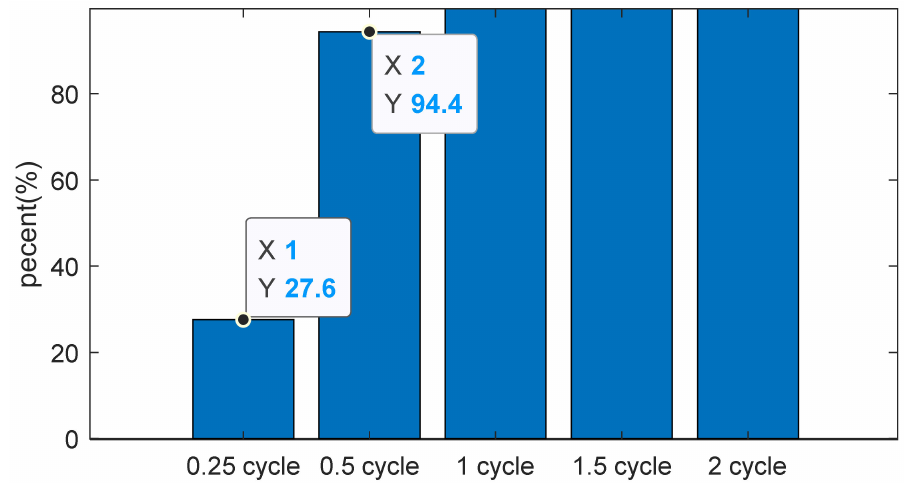
Figure 14. Model accuracy for open conductor fault location classification by input